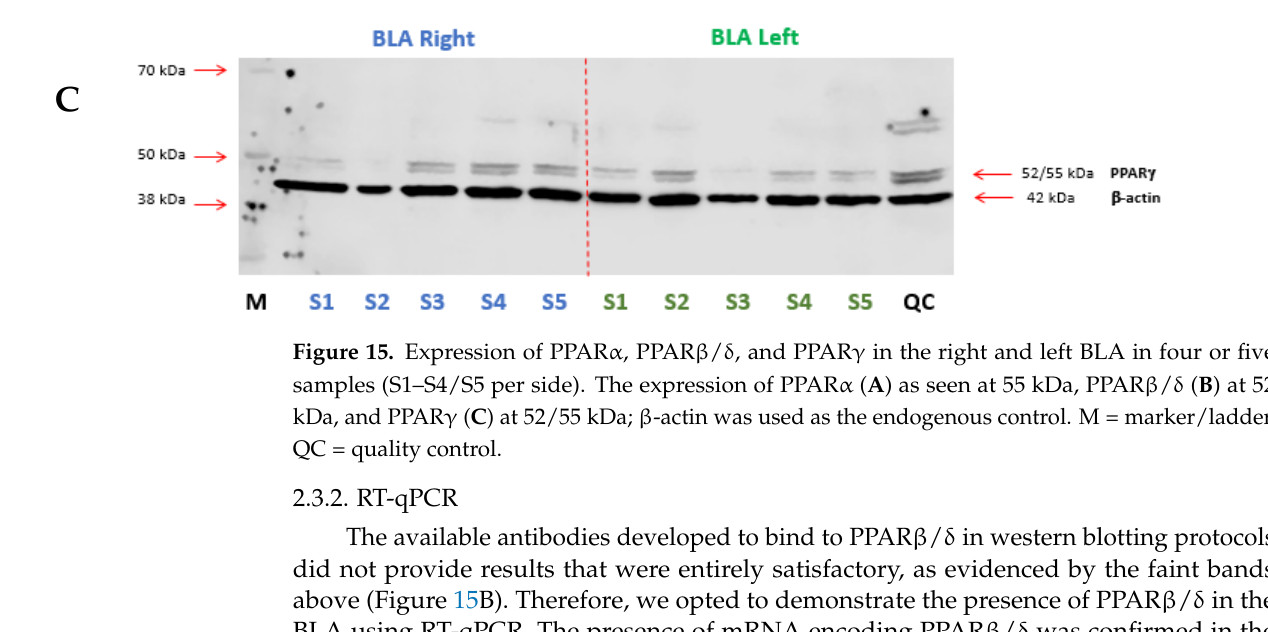
QC = quality control.